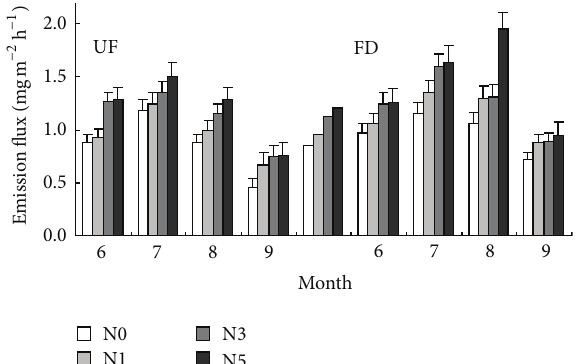
Figure 7: Effects of N-deposition on the wetland CH 4